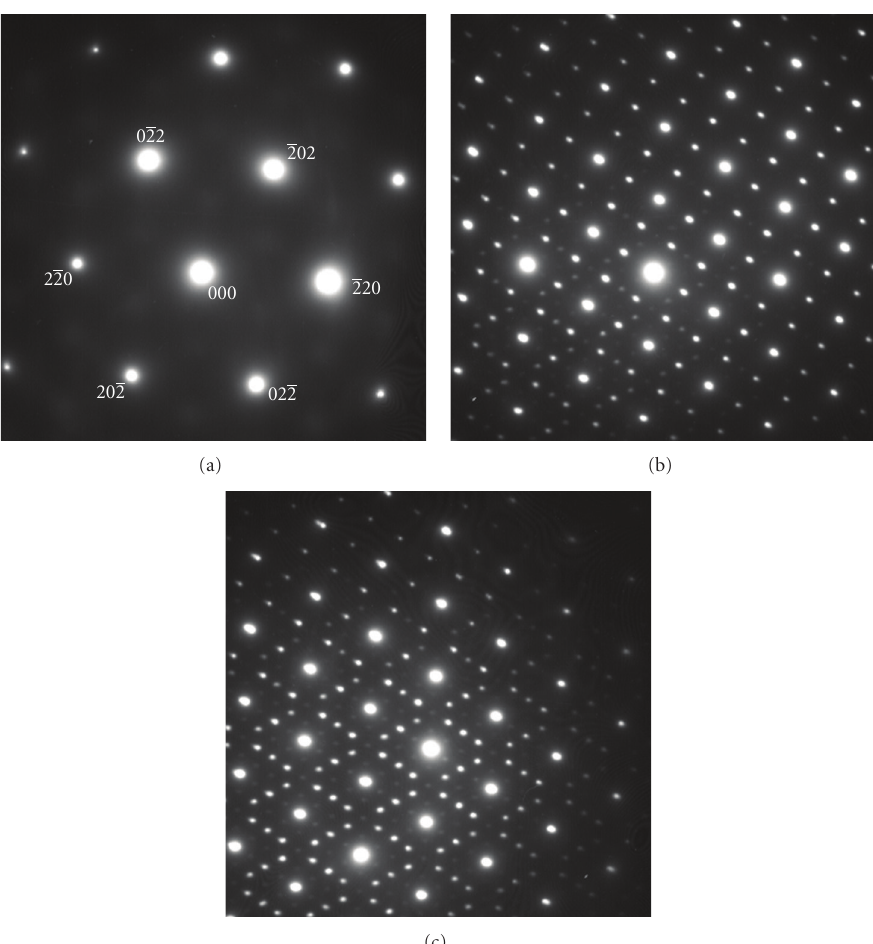
Figure 7: Experimental SAD patterns of the matrix (a) and in locations 1 (b) and 2 (c) of the precipitate shown in Figure 6. The patterns were identified as the [111] γ zone axis for the matrix (a) and the [010] δ for the delta plate (b). In location 2, a second variant of the delta phase appears together with that in location 1